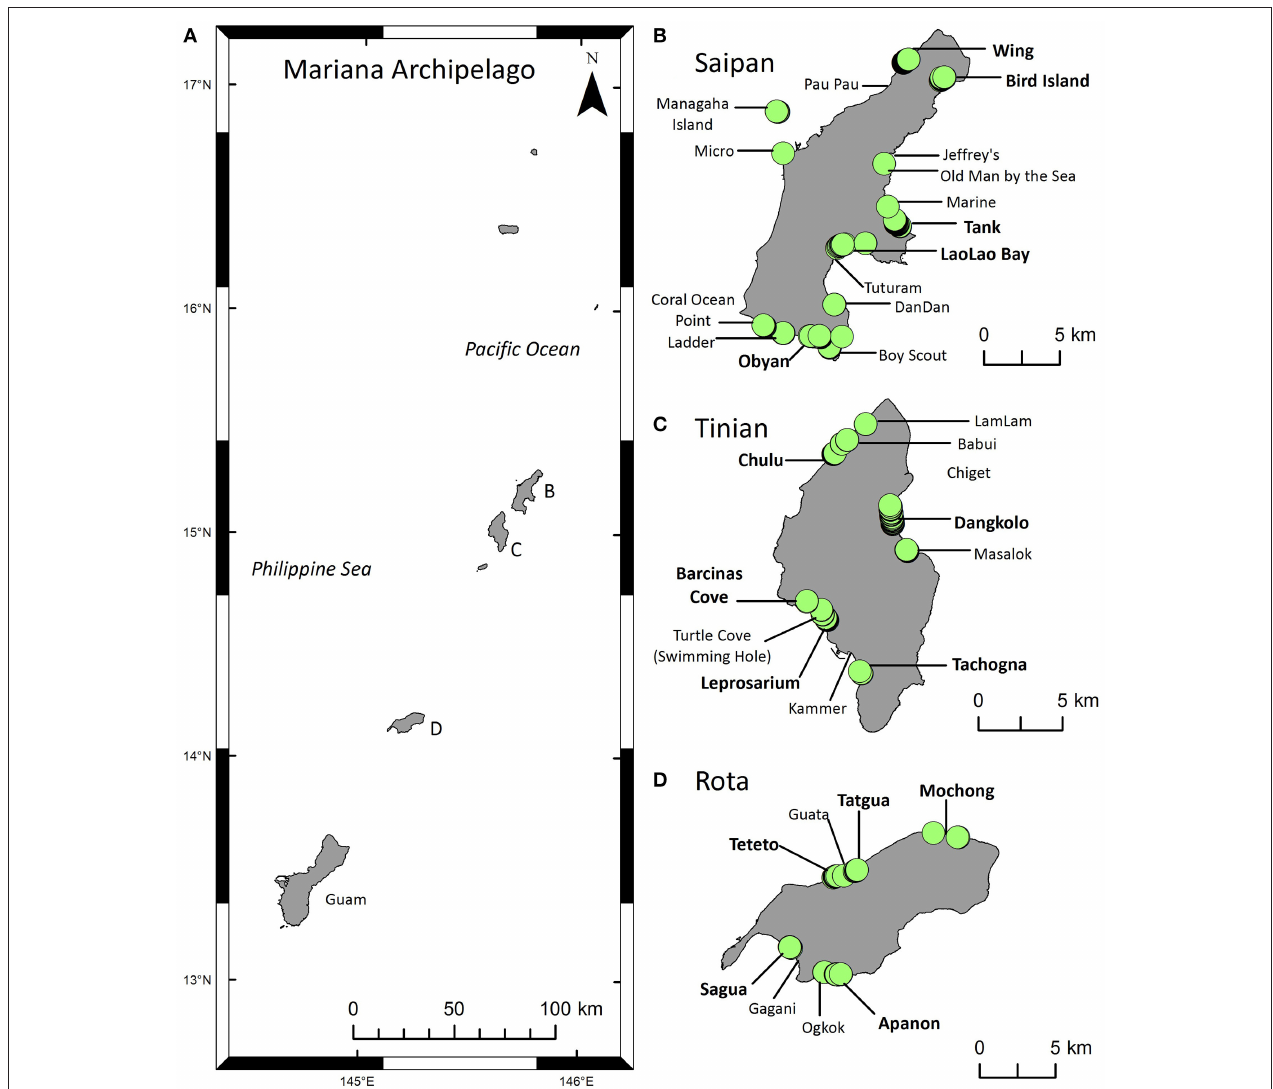
FIGURE 1 | Maps of the study area and green turtle ( Chelonia mydas ) nesting activity. (A) The Mariana Archipelago includes Guam at the southern end and the Commonwealth of the Northern Mariana Islands (CNMI) to the north. This study focuses on the southern CNMI islands of Saipan, Tinian, and Rota (B–D) where the majority of the CNMI human population lives. (B–D) Locations of index beaches (bold) and non-index beaches surveyed for nesting activity from 2006 to 2016. Green circles indicate locations of nests or other evidence of nesting activity recorded during beach surveys. The Supplementary Material contains a list of these